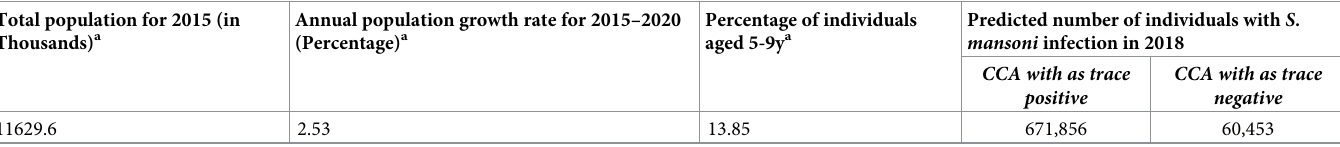
Table 3. Predicted number of individual boys aged 5 to 9 years estimated to be harbouring Schistosoma mansoni infection in Rwanda in 2018 based on results from two different diagnostic methods: CCA with trace as positive and CCA with trace as negative . CCA; Circulating Cathodic Antigen. Total population for 2015 (in Thousands)